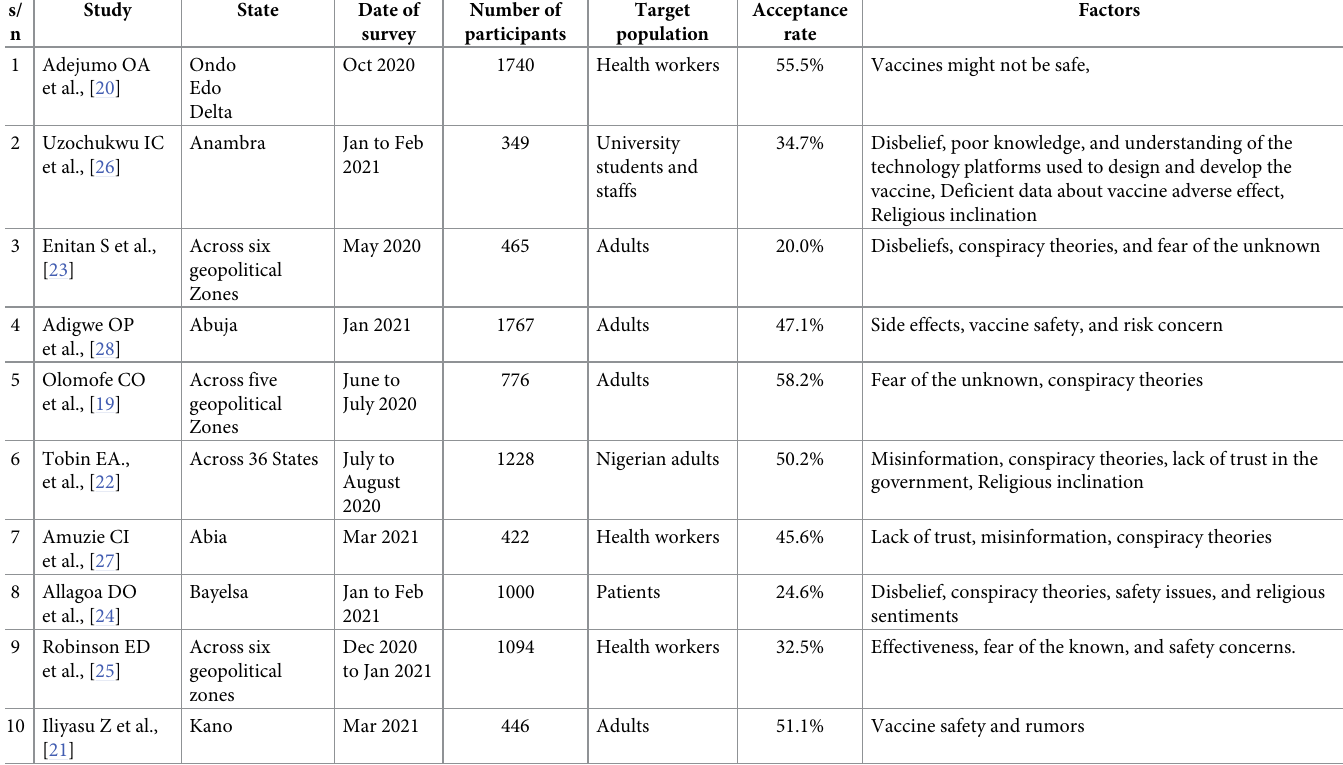
Table 2. Attributes of the eligible studies for the rapid review of COVID-19 vaccine acceptance in